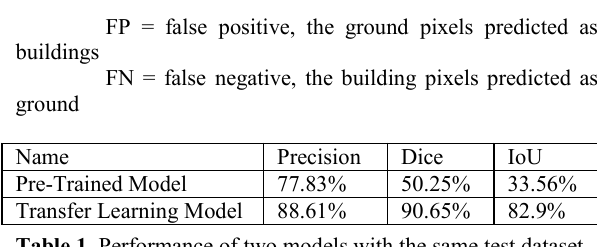
Figure 4 . Methodology process diagram of extracting village boundary automatically by computer vision algorithms and semantic segmentation images.